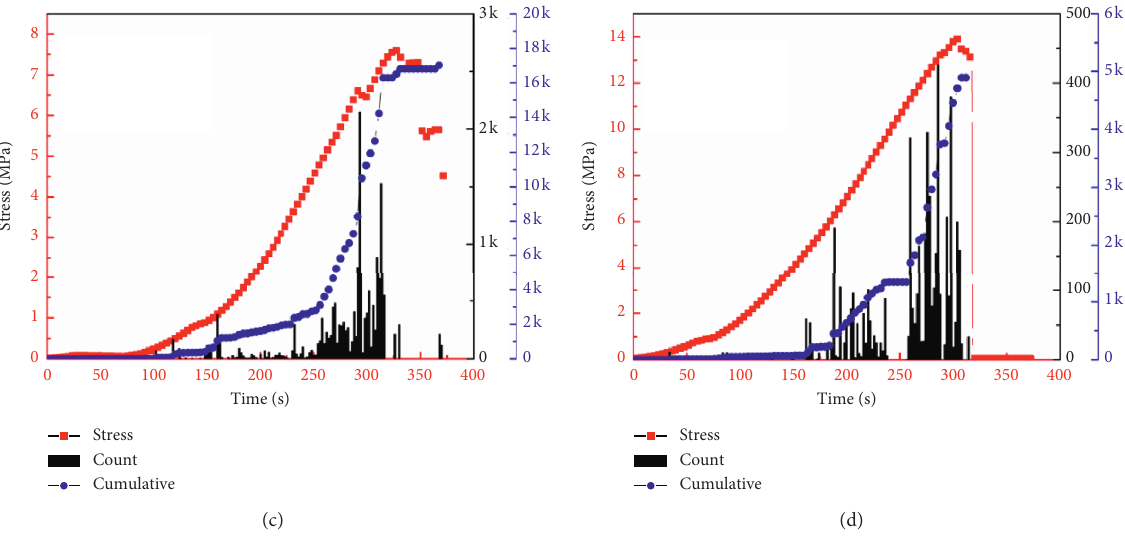
Figure 11: Relationship between AE energy, stress, and time (“count” represents AE energy count and “cumulative” represents AE cumulative energy count). (a) Coal sample no. 0. (b) Coal sample no. 2. (c) Coal sample no. 4. (d) Coal sample no.